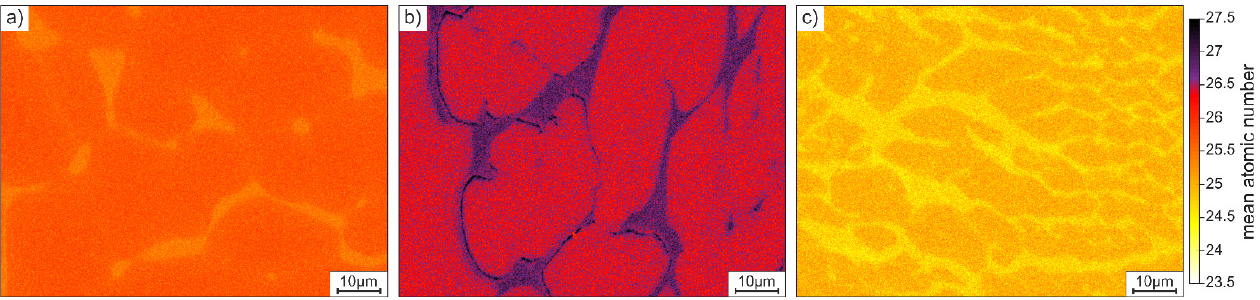
Figure 7. Distribution of the mean atomic number in the microstructure of ( a ) X2CrNi18 ‐ 9, ( b ) X2CrNiW15 ‐ 9 ‐ 5, and ( c ) X2CrNiSi18 ‐ 9 ‐ 4. ( b ) X2CrNiW15-9-5, and ( c )